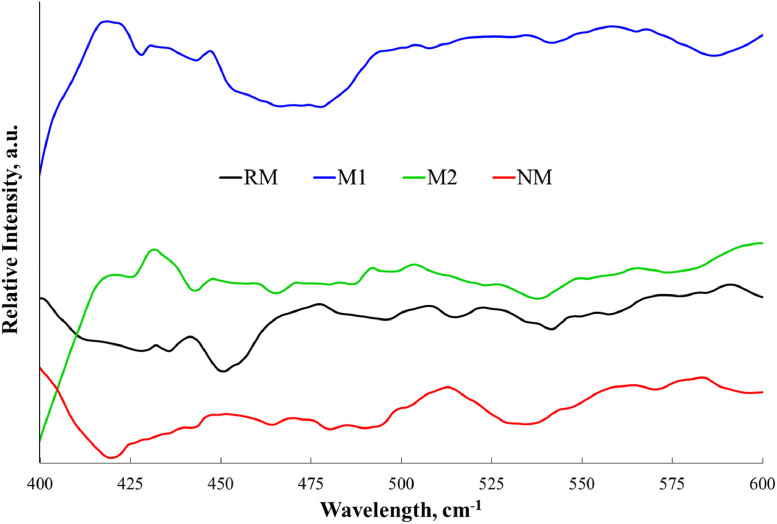
FTIR spectra for fractions obtained from black mineral sand. Adapted from [6].